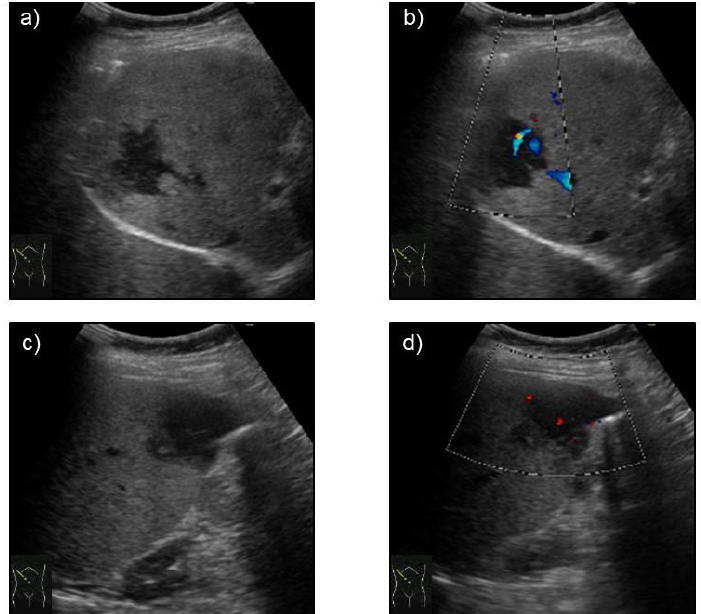
Figure 1. B-mode ultrasonography depicted a hypo-echoic tumor lesion at segment S8 in the liver ( a ), through which a penetrating vessel was visualized by color Doppler imaging ( b ). B-mode ultrasonography showed a hypo-echoic tumor lesion at segment S5 in the liver ( c ), through which a penetrating vessel was visualized by color Doppler imaging ( d ).